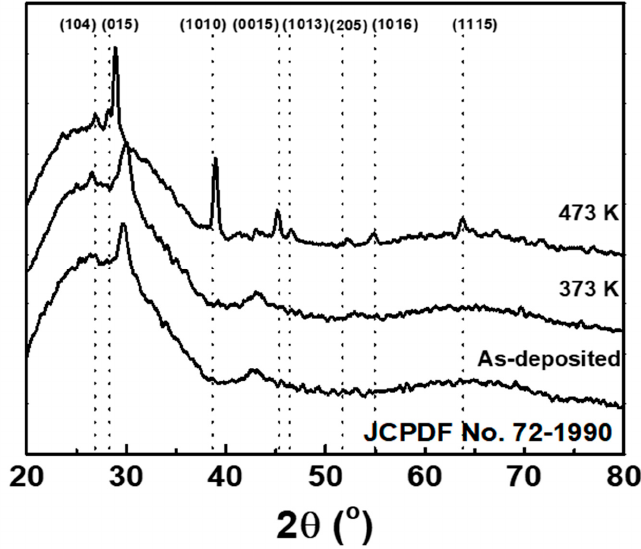
Figure 2. X-ray diffraction patterns of as-deposited Sb 2 Te 3 (100 nm thickness) film and after annealing at 373 or 473 K.